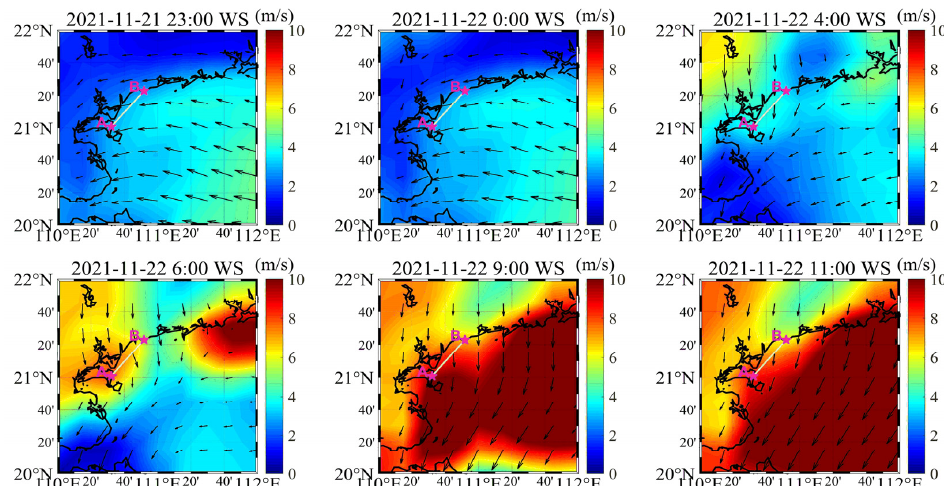
Figure 12. Spatial distribution of RH in the study area at the six typical times.